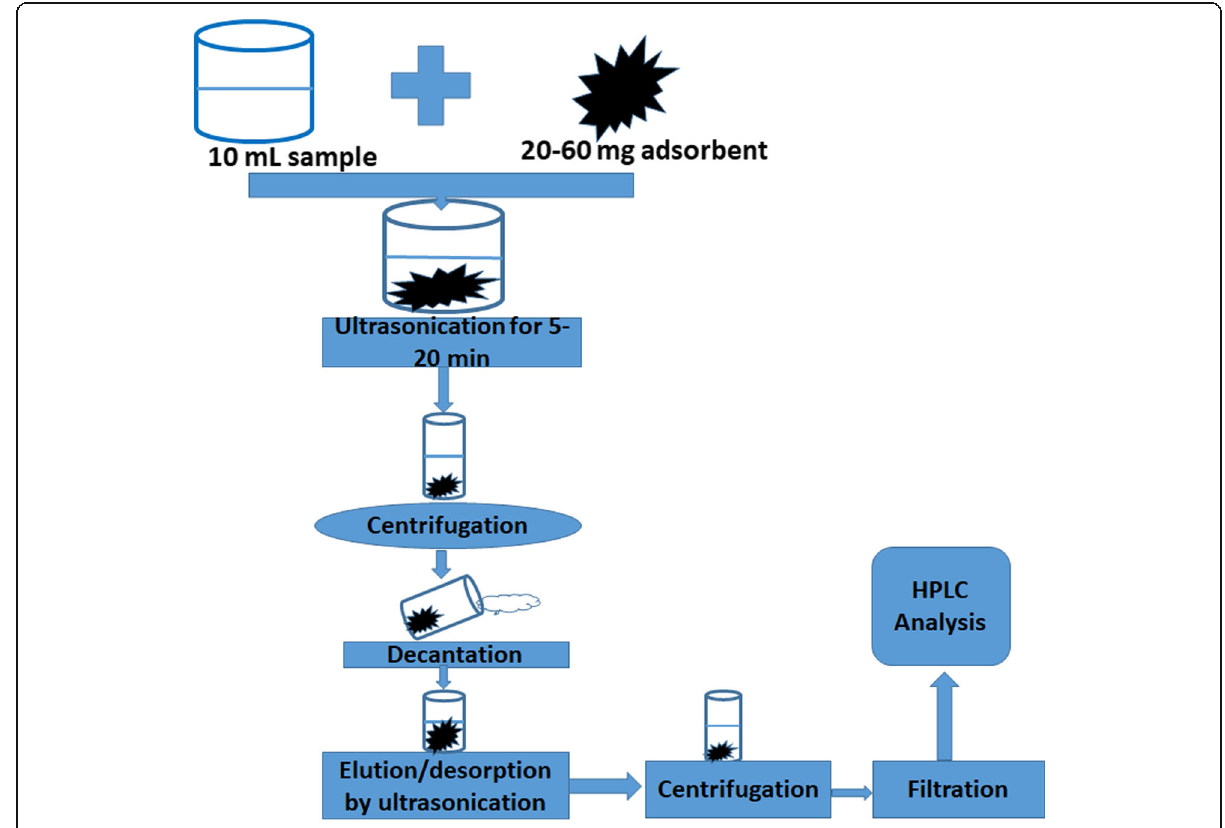
Fig. 2 Flow diagram showing the extraction and preconcentration steps